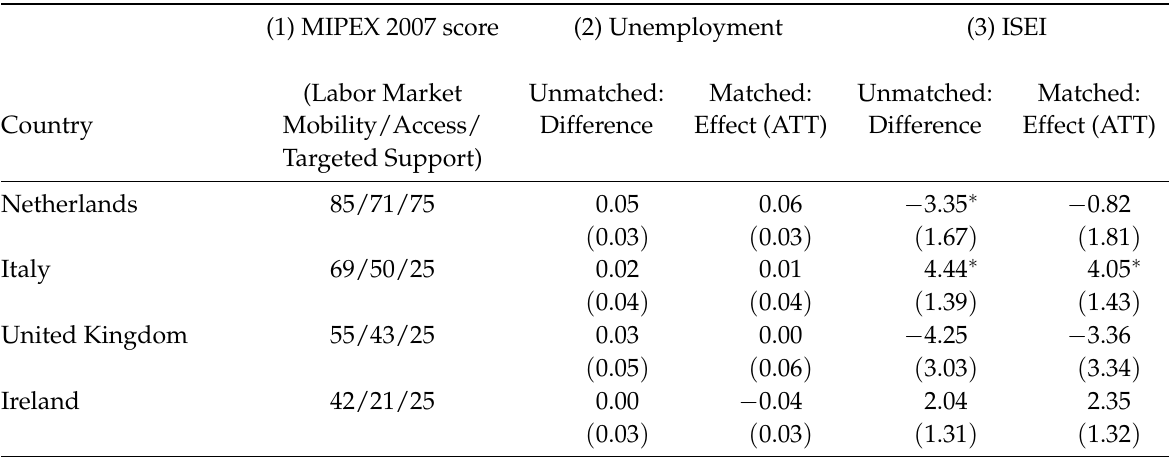
Table 3: Difference between Control and Treatment Groups in the Outcomes of Labor Market Training before and after